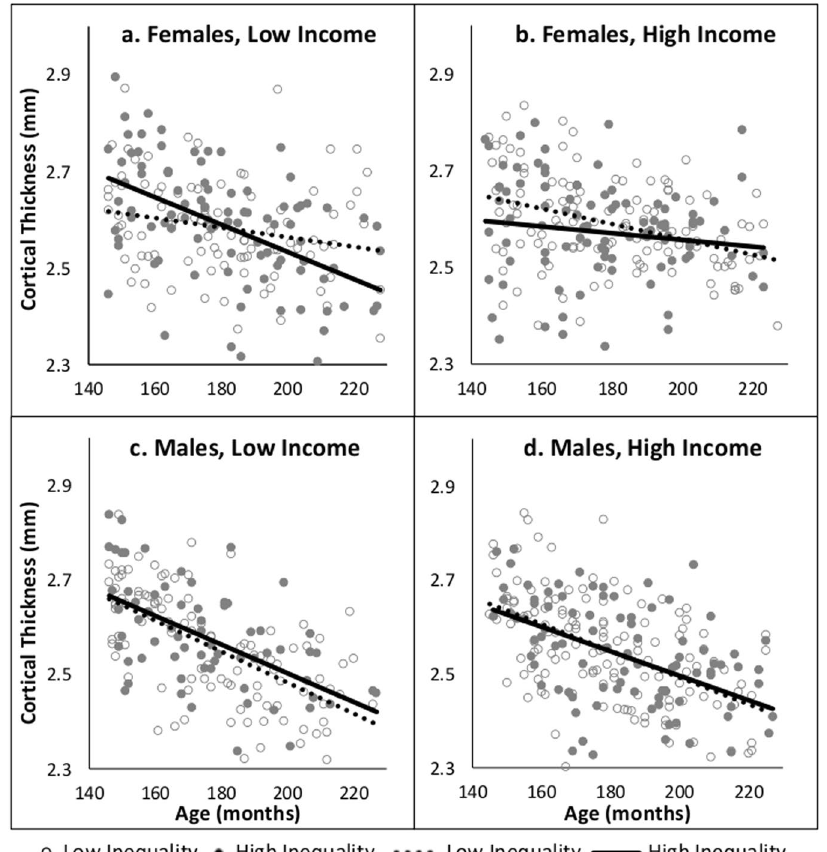
Figure 1. Mean cortical thickness by age in male and female income (low, high) groups. Within each income group plot inequality subgroups are stratified: high = solid circles and solid line, low = hollow circles and dashed line. In predicting cortical thickness, the interaction between age by inequality was analyzed for each male and female income